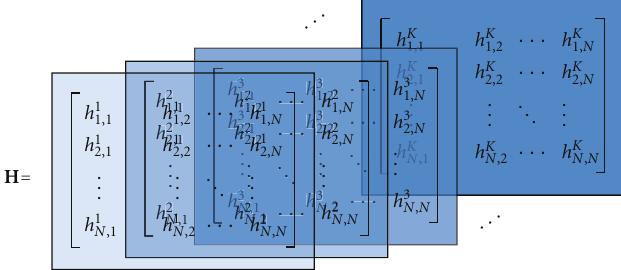
Figure 2: MIMO channel matrix H of dimension N × N × K